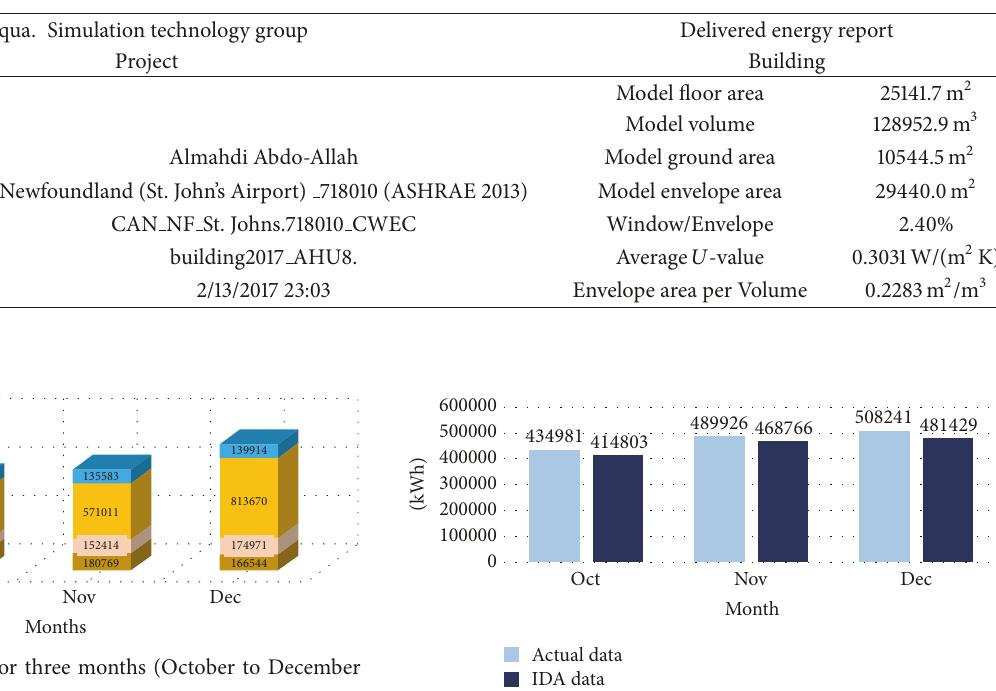
Table 1: Details of the building.